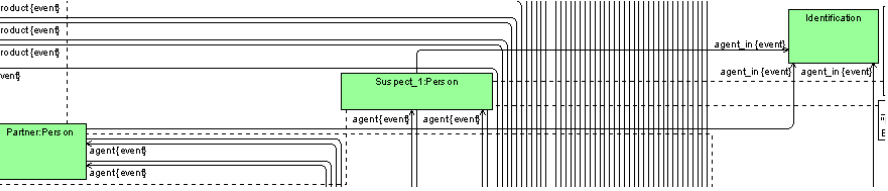
Fig. 10. Relation between partner and